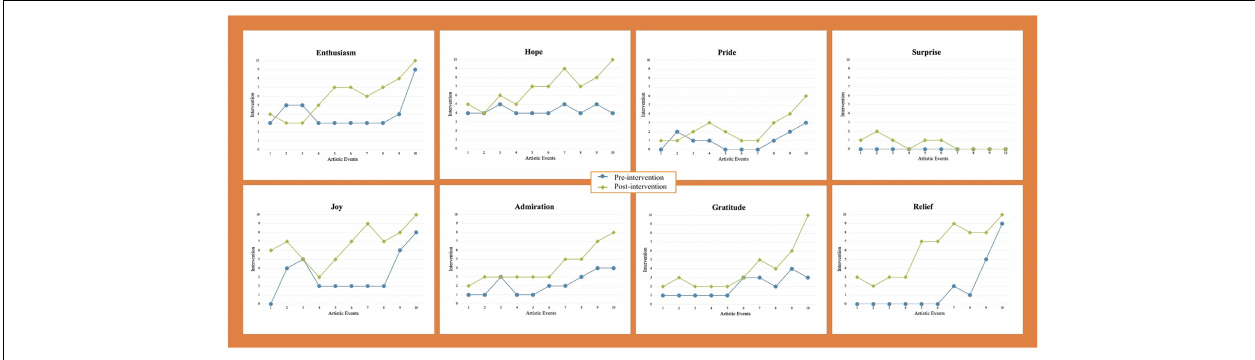
FIGURE 2 | Visual direction for positive emotions. NB: Pre-intervention is represented by a blue line; Post-intervention is represented by a green line.